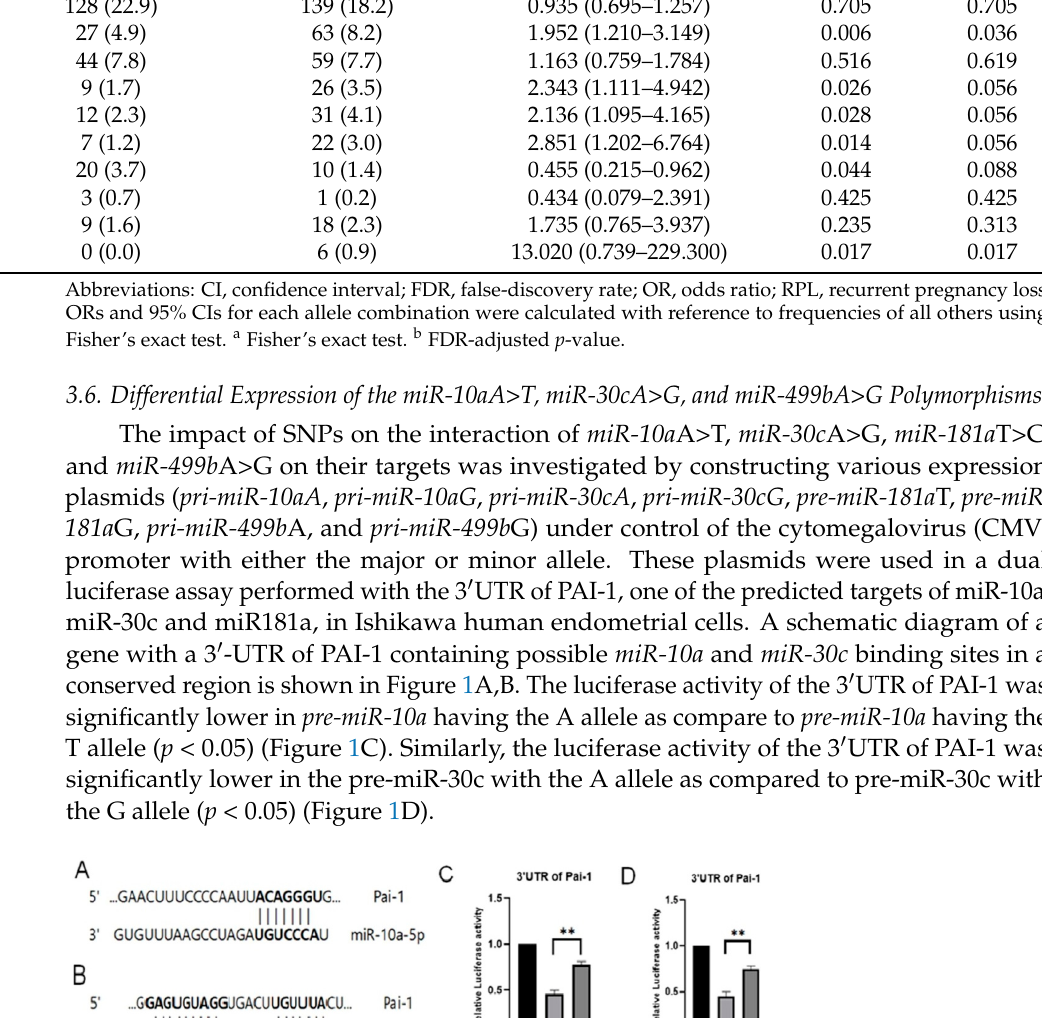
Table 5. Allele combination analysis of miRNA polymorphisms in recurrent pregnancy loss patients and control subjects.